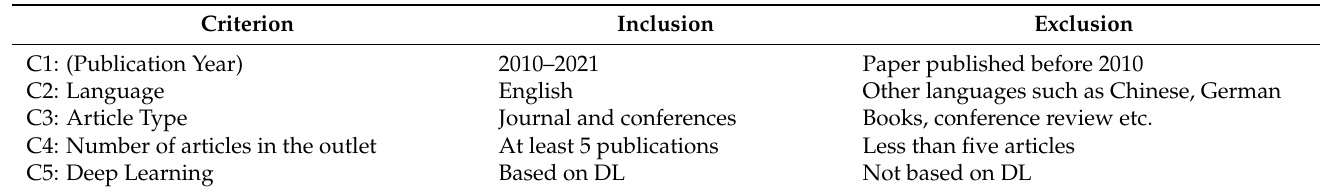
Table 2. Inclusion and exclusion criteria followed to extract relevant